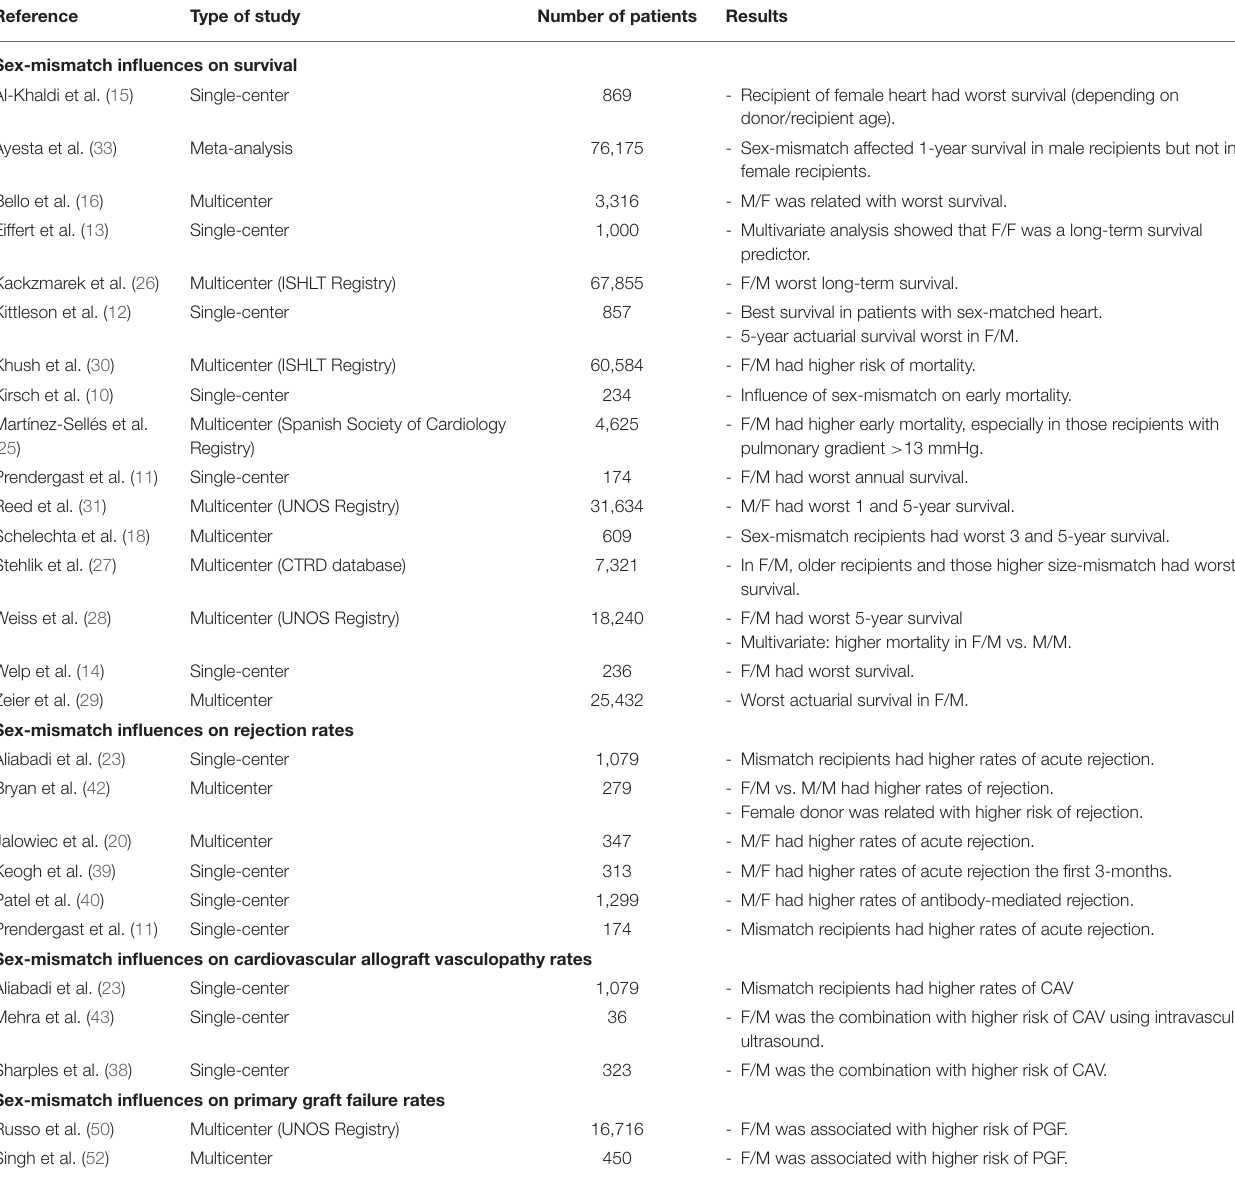
TABLE 1 | Summary of the main studies showing the influence of sex-mismatch on higher rates of mortality, rejection, cardiovascular allograft vasculopathy, and primary graft failure.